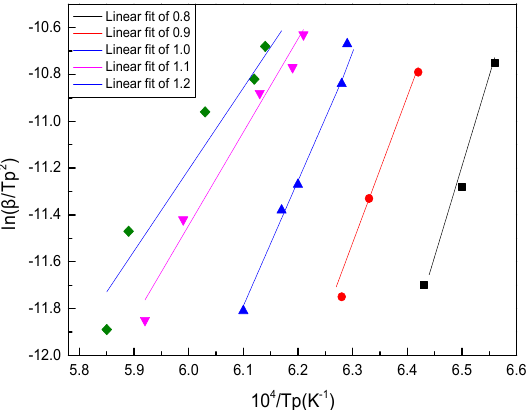
Figure 9. Crystallization activation energy ( E ) calculated using the Kissinger method.